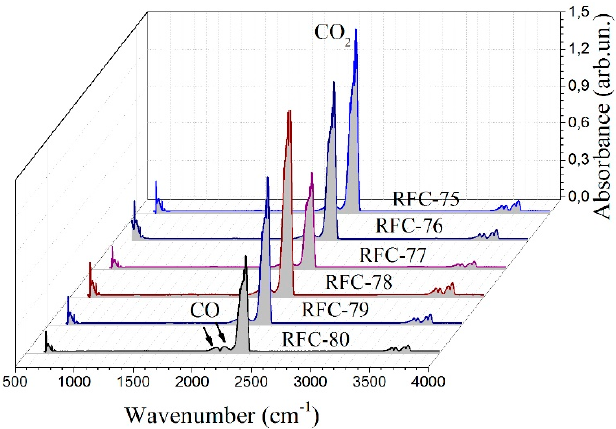
Figure 6. FTIR spectra of the carbonized composites heated at 540–570 °C.